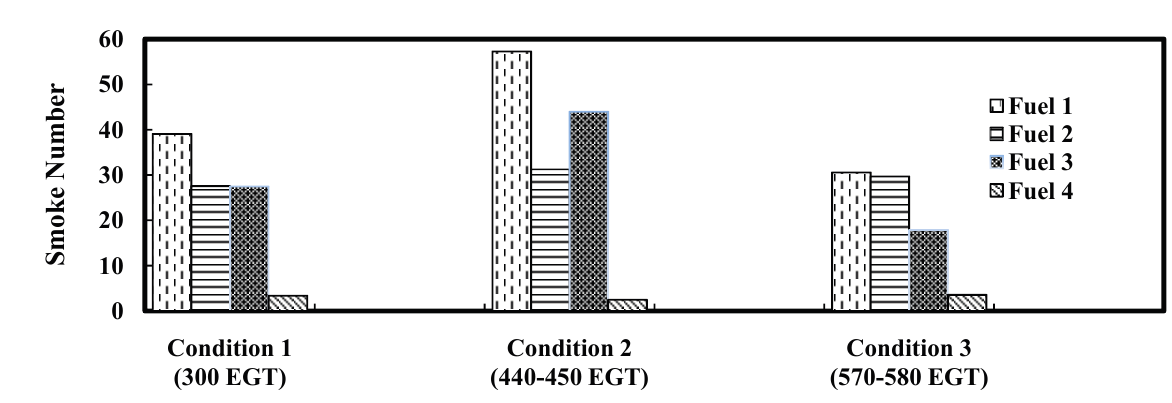
Figure 9. Smoke Number for different fuels at various loads.